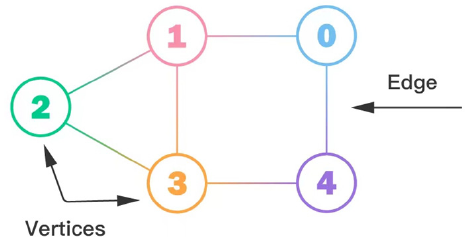
Figure 2. An example graph.